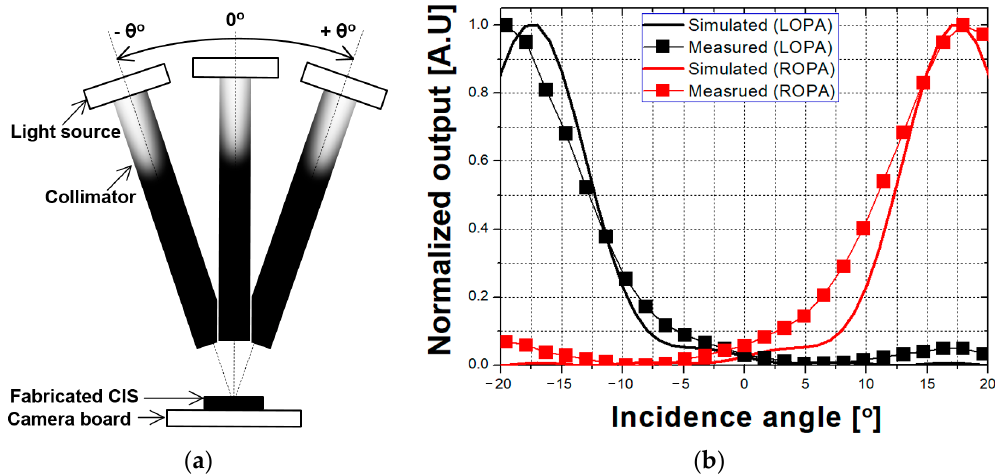
Figure 9. ( a ) Measurement system used to evaluate performance of the fabricated CIS using the OPA technique according to the incidence angle and ( b ) comparison of the simulation and measurement